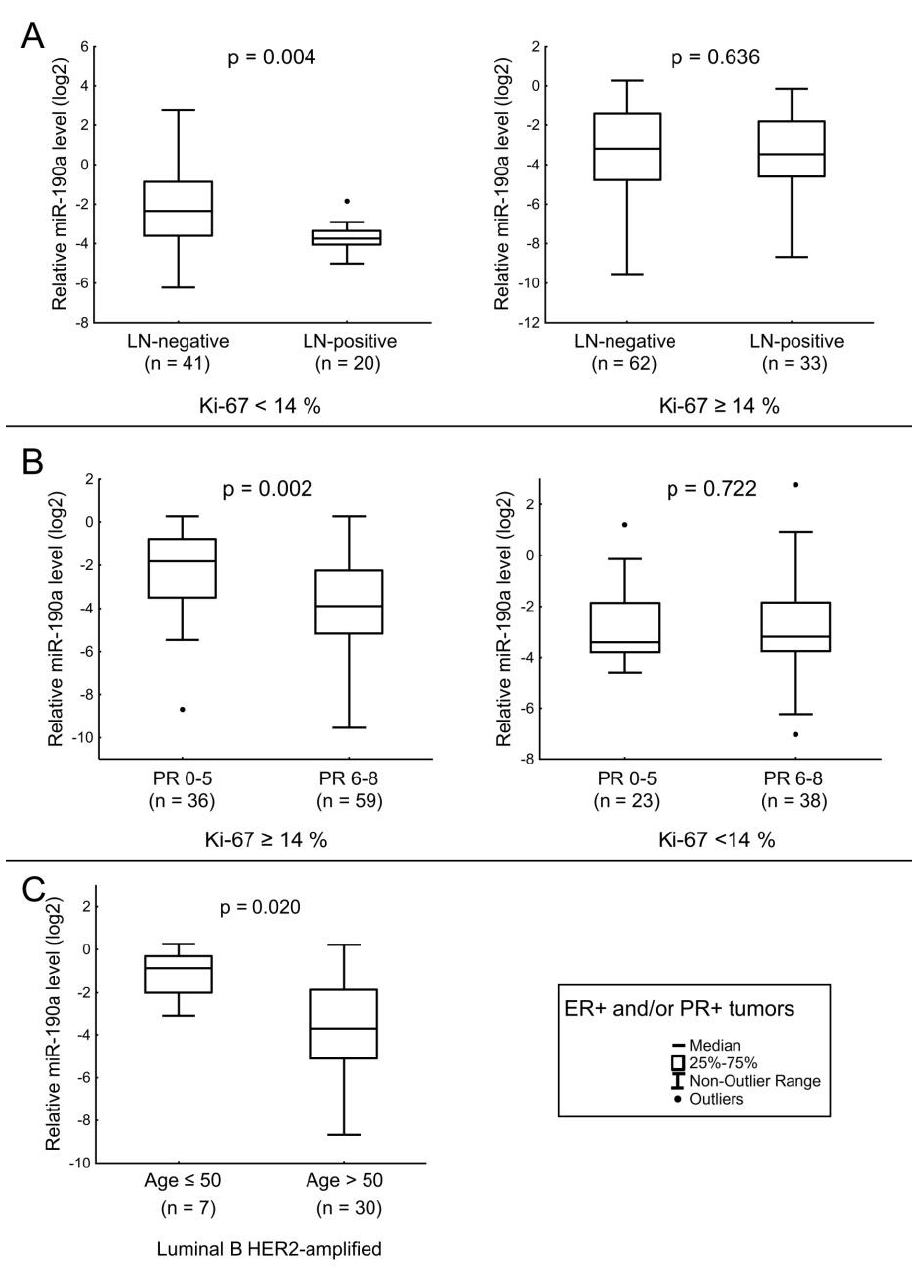
tumors (Figure 5A). A lower level of miR-193b in tumor tissues of patients with LNM was observed in all cases, except for tumors with HER2 1+ expression (Figure 5B). Since most cases with low ER expression belong to the luminal B HER2 0 variant, we separately assessed the association of miRNA with ER and PR expression in this BC type (Figure 5C).